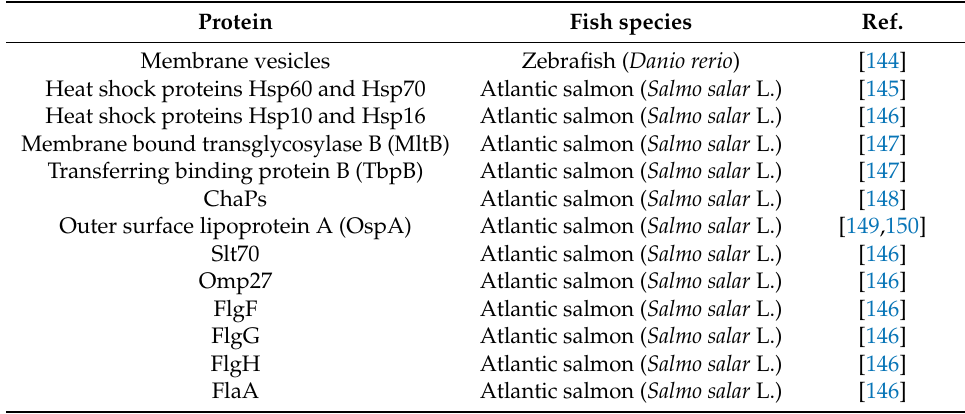
Table 4. Piscirikettsia salmonis immunogenic proteins used in recombinant vaccine production. Protein Fish species